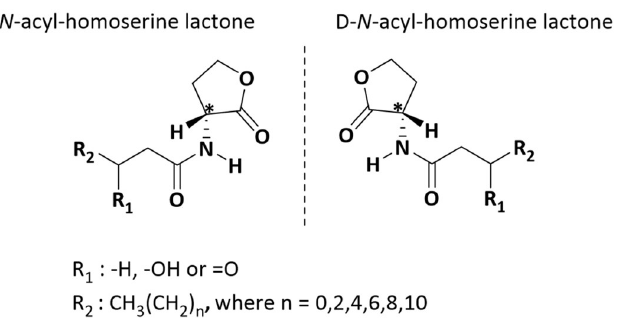
Fig 1. Structure of D,L- N -acyl homoserine lactones. R 1 represents the substitution on the third position of the acyl chain and R 2 represents the length of the acyl chain.